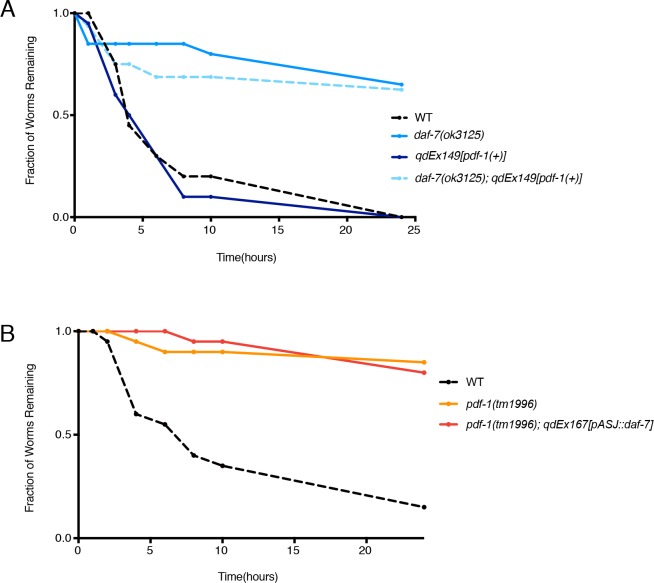
The PDF-1 pathway regulates mate-searching behavior via male-specific modulation of daf-7 expression in ASJ and through parallel mechanisms.(A) Representative mate-searching data curves for WT (dashed black), daf-7 mutant (light blue), pdf-1(+) transgenics (dark blue), and the daf-7; pdf-1(+) double (light blue dashed) males. n = 20 animals for each curve shown except for daf-7;pdf-1(+) where n = 16 animals. (B) Representative mate searching data curves for WT (dashed black), pdf-1 mutant (orange), and pdf-1 mutant males with daf-7 overexpressed from ASJ (red). n = 20 for all genotypes.